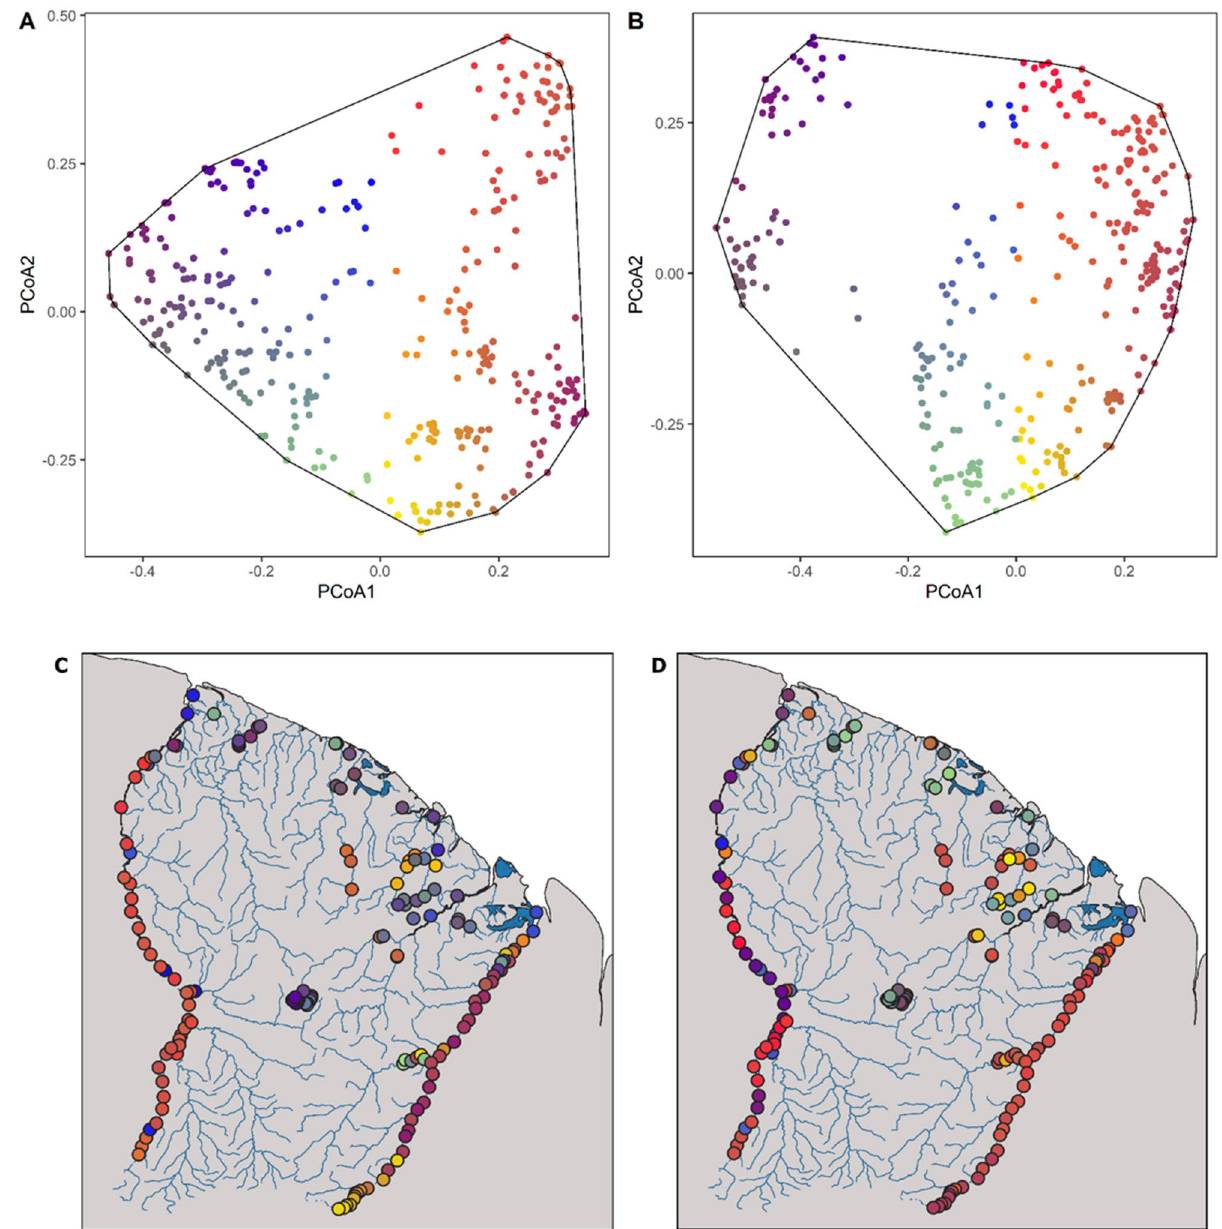
Figure 1. Principal coordinate analysis (PCoA) of species composition dissimilarity between filters. ( A ) Ordination of filter species composition dissimilarity in the outputs of OBITools. ( B ) Ordination of filter species composition dissimilarity in the outputs of the CNN applied to raw reads. Dissimilarity matrices were built with Bray–Curtis distances on read abundance per species per filter. ( C ) Maps of the filter locations, coloured according to the position of the filters in the PCoA space for OBITools outputs. ( D ) Maps of the filter locations, coloured according to the position of the filters in the PCoA space for the CNN applied to raw reads outputs. The maps were created with QGIS